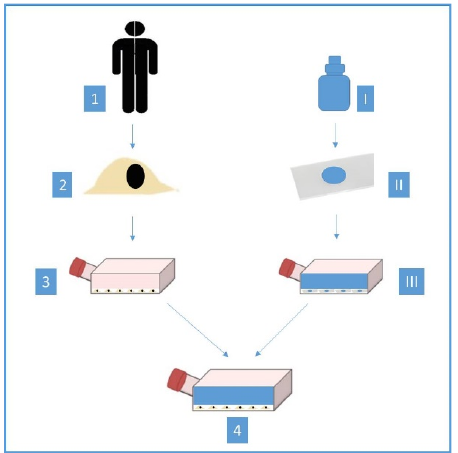
Figure 1. The method of the cytotoxicity assay (1 = biopsy of normal human gingival tissue, 2 = isolation of fibroblast cells, 3 = cultivation of fibroblast cells, I = different dentin adhesives, II = adhesives were applied centrally to the sterile bases of glass slides, III = eluate was obtained, 4 = eluate added to fibroblasts in Petri dishes).